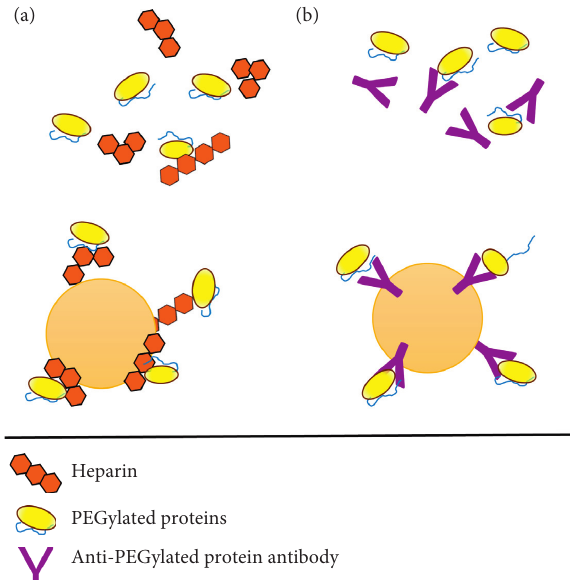
Figure 3: Improved affinity by immobilizing PEGylated protein ligands on multivalent